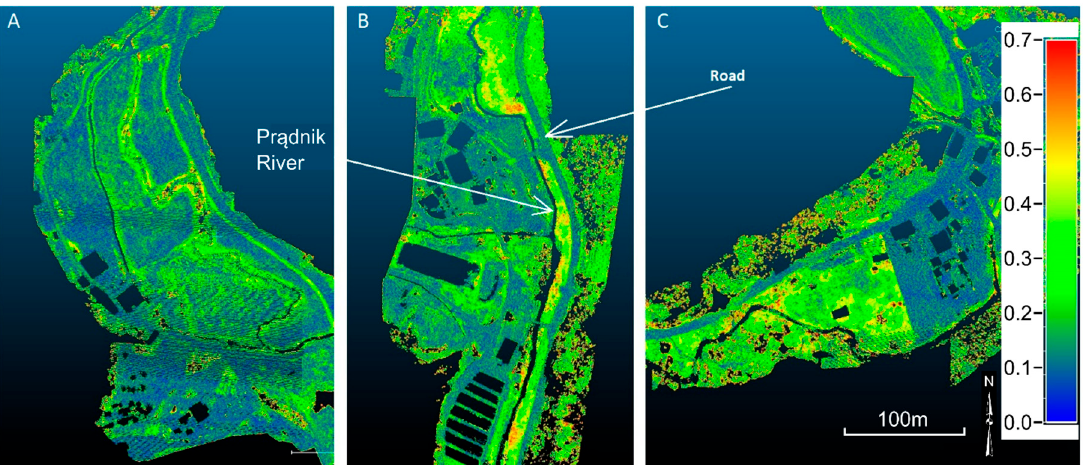
Figure 6. Di ff erence in height between the point clouds, the Pr ˛adnik River is not represented by Figure 6. Difference in height between the point clouds, the Pr ą dnik River is not represented by points, the road is constantly represented in blue, di ff erence in height is minimal. ( A )—minimal points, the road is constantly represented in blue, difference in height is minimal. A —minimal di ff erence between point clouds, ( B )—largest di ff erence in height between the river and the road, difference between point clouds, B —largest difference in height between the river and the road, C — ( C )—largest di ff erence on the east bank in a non-urbanised area (visible di ff erence between urbanised largest difference on the east bank in a non-urbanised area (visible difference between urbanised and and non-urbanised non-urbanised area).